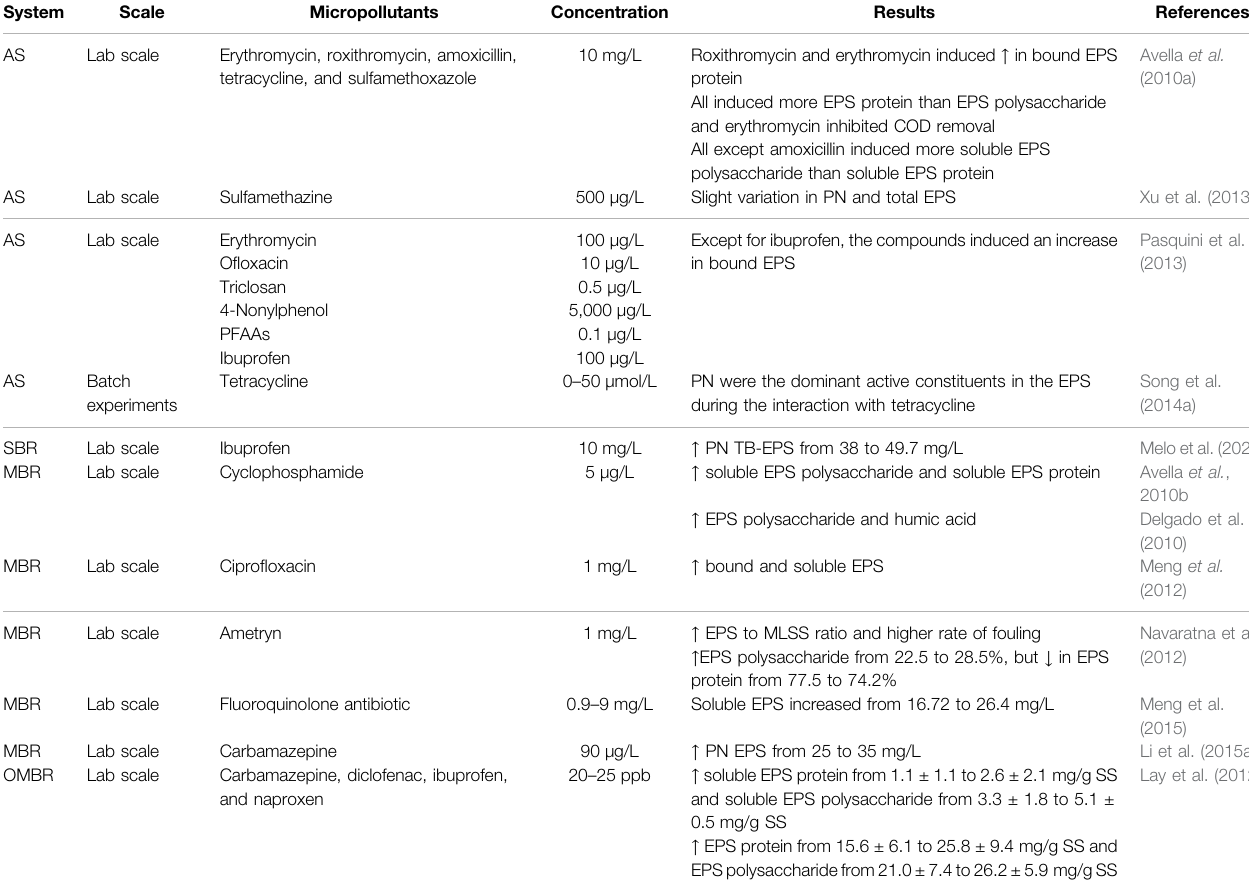
TABLE 2 | Effect of different micropollutants on EPS production and composition.